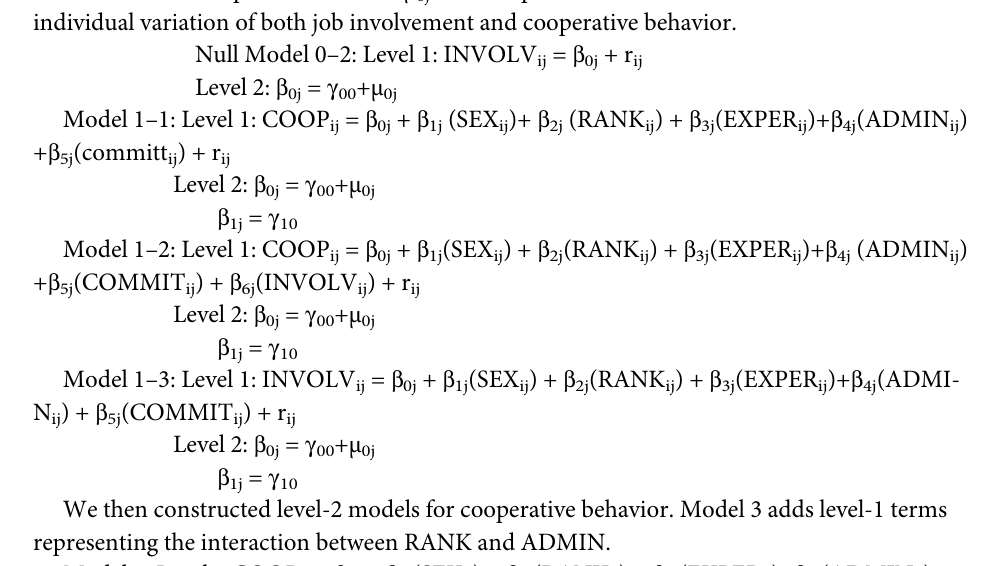
behavior across sampled schools and μ the unexplained level-2 variance. Next, we model the 0j individual variation of both job involvement and cooperative behavior.